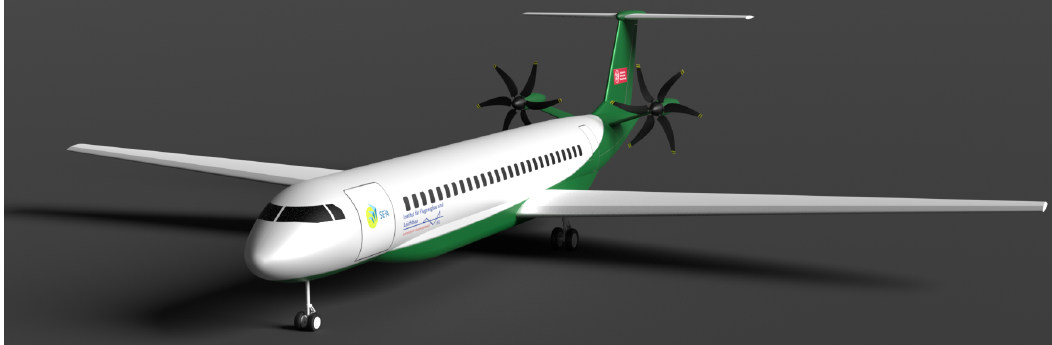
Figure 15. SE 2 A SR aircraft